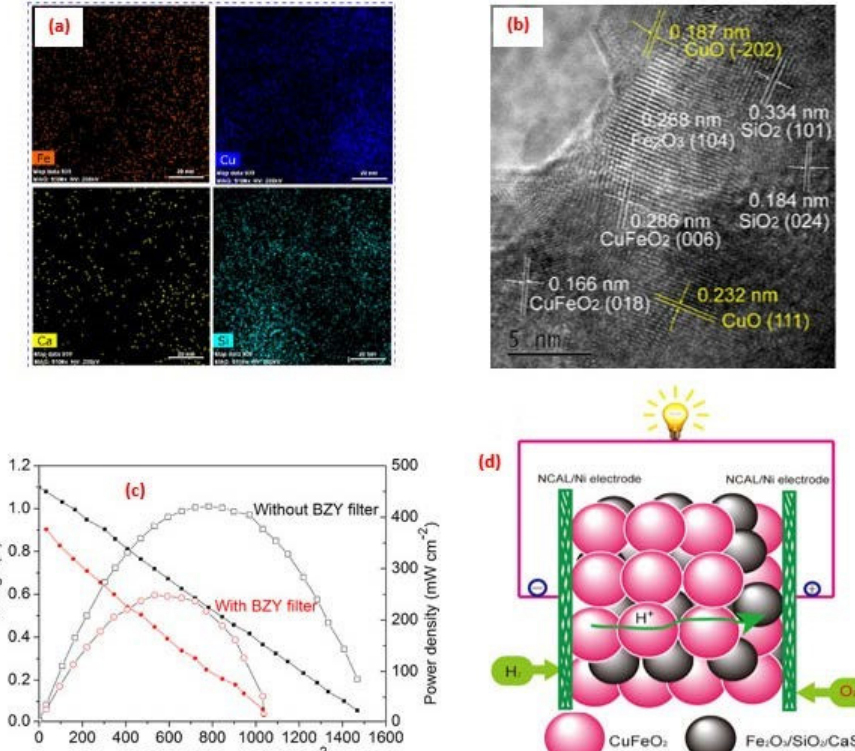
Figure 6. ( a ) The EDS elemental mapping (Fe, Cu, Ca, and Si elements); ( b ) HRTEM image of CuFe-oxide; ( c ) I – V and power density of CuFe-oxide cells with and without BaZr 0.8 Y 0.2 O 3- δ filters under H 2 /air at 550 ◦ C; and ( d ) the underlying mechanism of the CuFe-oxide fuel cell depicted schematically. Copyright 2018 by the American Chemical Society